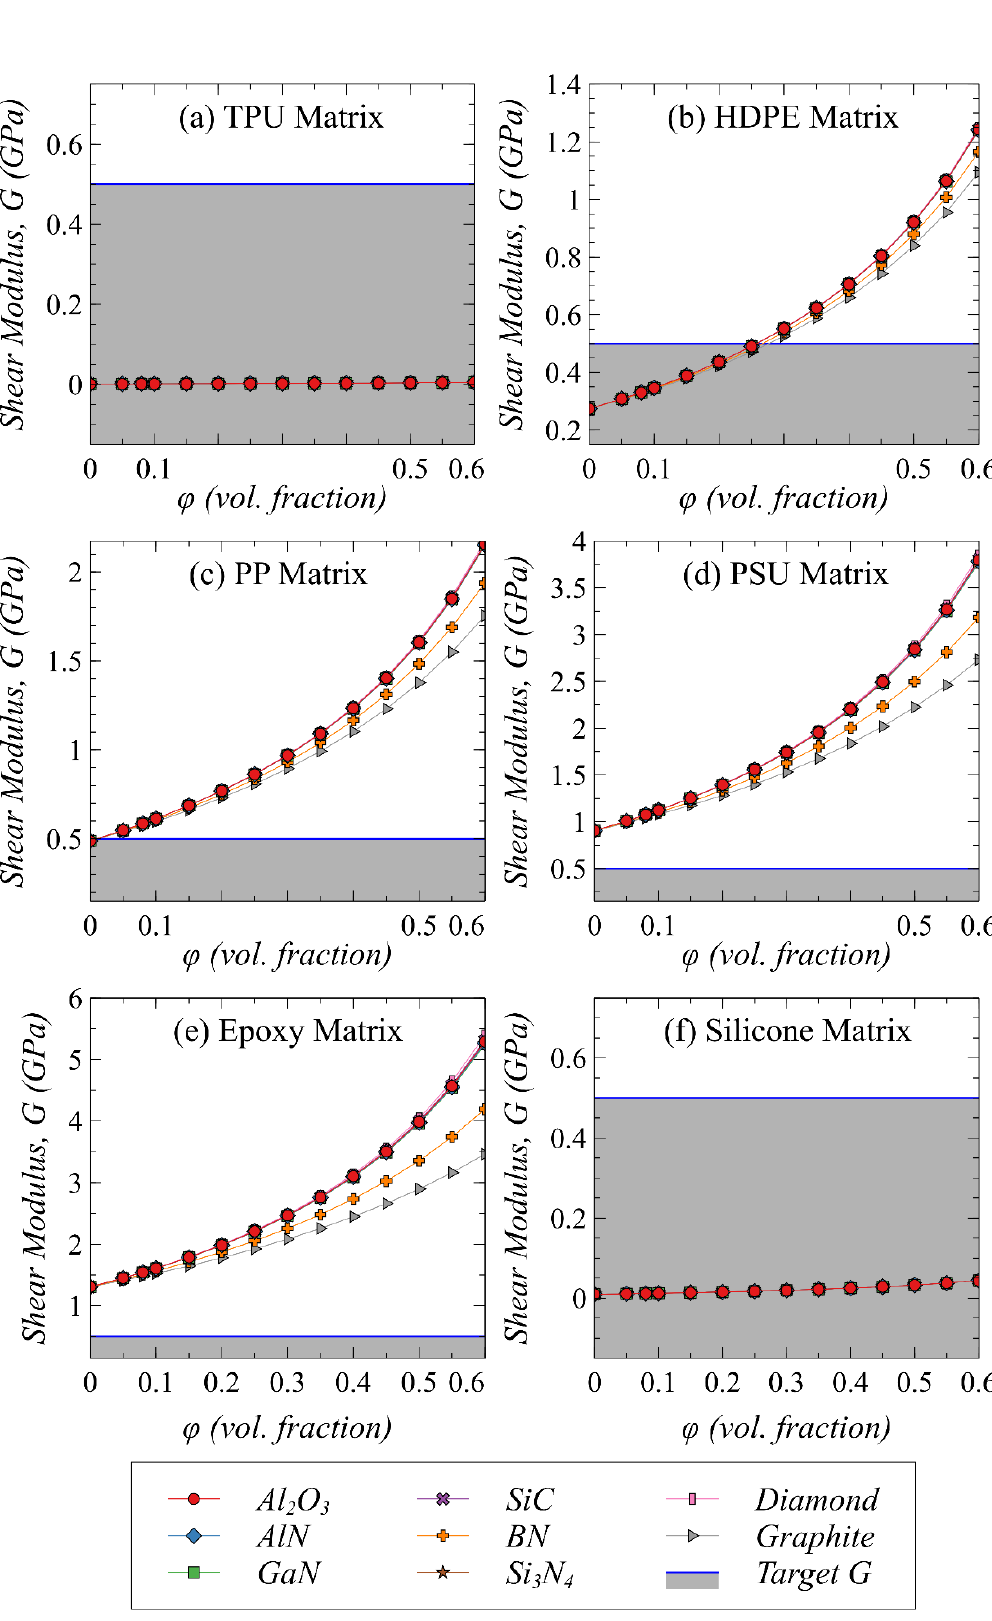
Figure 4. The predicted effective shear modulus of composites with different polymer–filler combinations.